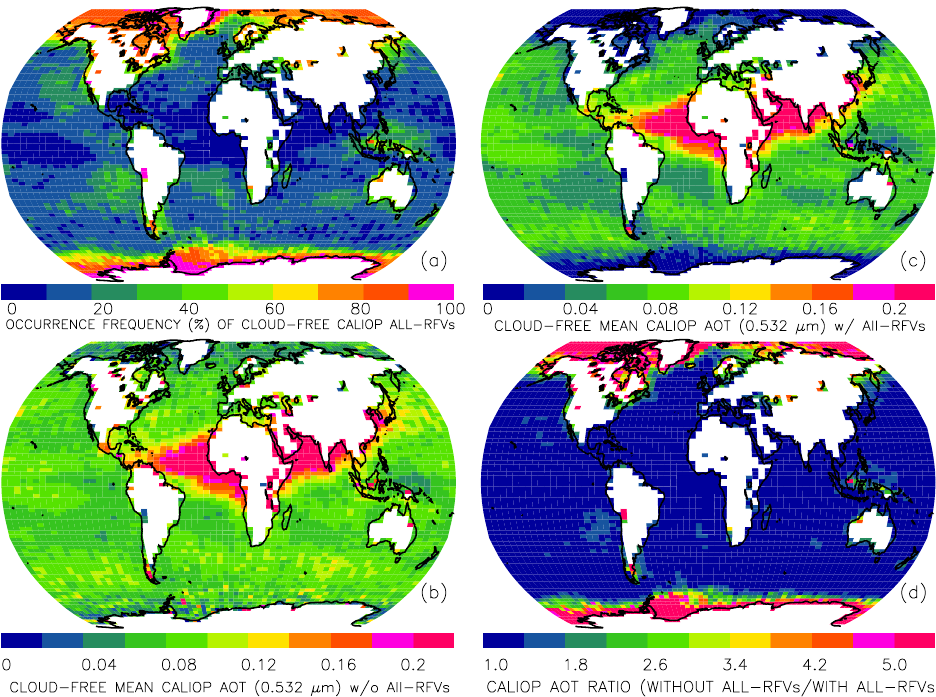
Figure 3. For 2010–2011, (a) the frequency of occurrence (%) of cloud-free CALIOP profiles at 2 ◦ × 5 ◦ latitude–longitude grid spacing. Also shown are the corresponding cloud-free mean CALIOP column AOTs (b) without and (c) with all-RFV profiles, and (d) the ratio of (b) to (c)